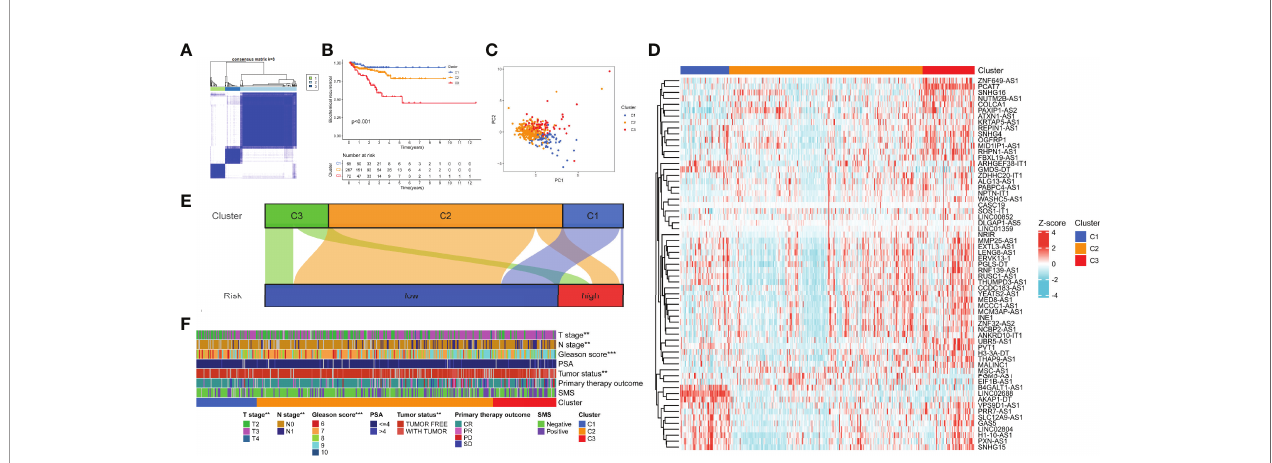
FIGURE 12 | Identi fi cation of m7G-related patterns by consensus matrix factorization. (A) Consensus matrix. (B) BCR-free survival in m7G phenotypes with Kaplan – Meier curves. (C) The expression characteristics of m7G-related lncRNAs of m7G phenotypes with PCA diagram. (D) Expression of the m7G-related lncRNAs in m7G-related patterns. (E) Distribution of samples in m7G-related patterns in the high- and low-risk groups with Sankey diagram. (F) Correlations between m7G-related patterns and clinicopathological parameters. m7G, 7-methylguanosine; BCR, biochemical recurrence; lncRNAs, long non-coding RNAs;